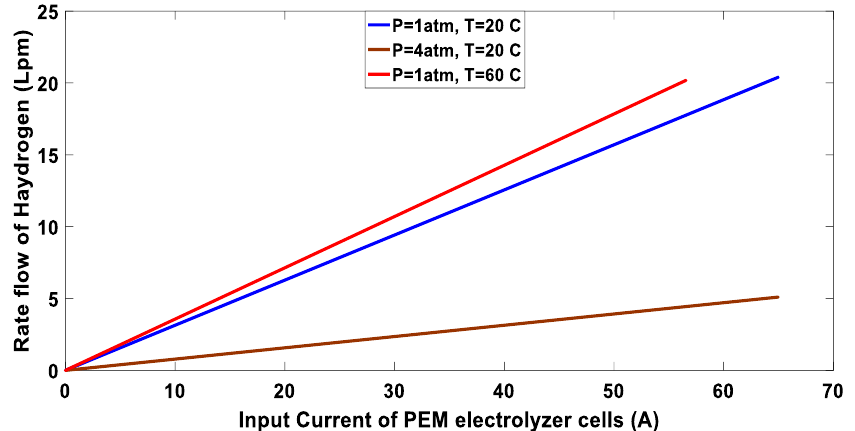
Figure 22. The Stator current for the desired speed, 50 rad/s, for ( a ) fuzzy PID based PSO and ( b ) fuzzy-PID-based C-BO.